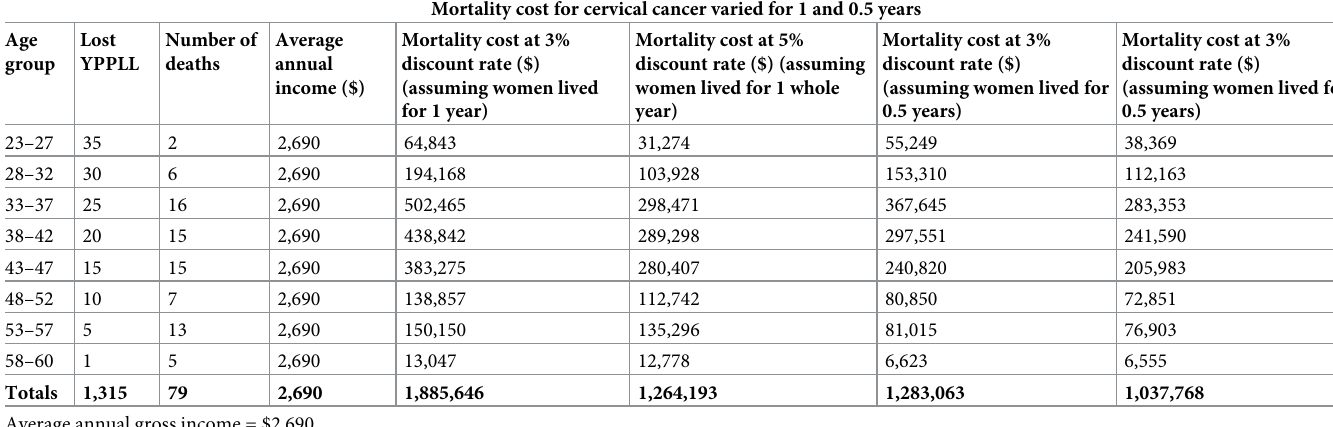
Table 8. Estimating mortality